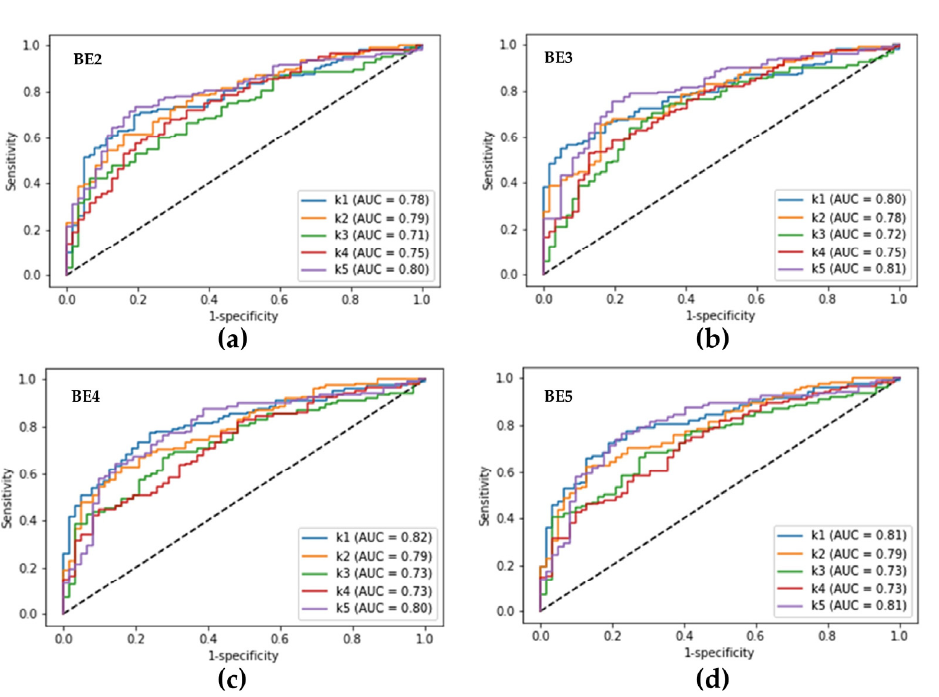
Figure 4. Receiver operating characteristic curves obtained from the fivefold cross-validation of the best ensemble models for diagnosing Pseudomonas keratitis. ( a ) Receiver operating characteristic (ROC) curves of the best ensemble 2-deep learning model; ( b ) ROC curves of the best ensemble 3-deep learning model; ( c ) ROC curves of the best ensemble 4-deep learning model; ( d ) ROC curves of the best ensemble 5-deep learning model. BE2, BE3, BE4, and BE5 represent the best ensemble 2-, 3-, 4-, and 5-deep learning models. k1 to k5 represent the obtained ROC curves from the five test results of fivefold cross-validation. AUC, the area under the ROC